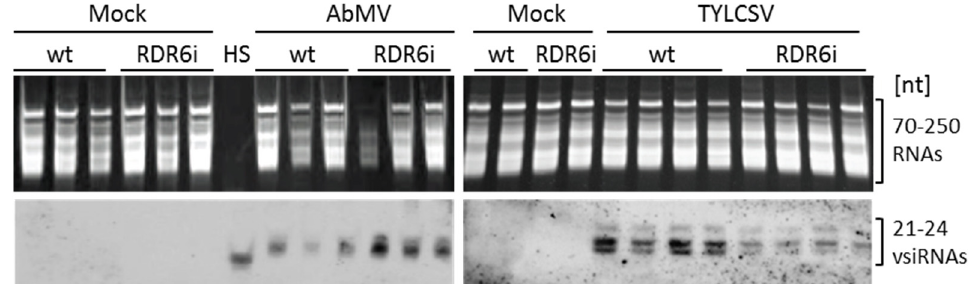
Figure 4. Northern blot analysis of virus-derived siRNAs in wild type (wt) or RDR6i Nicotiana benthamiana plants, either mock-inoculated (control) or infected by either AbMV or TYLCSV. vsiRNAs were detected using PCR-ampli fi ed, digoxigenin-labelled, full-length virus DNA probes via chemiluminescence. Small RNA ( ≈ 70 to ≈ 250 nt apparent lengths) loads of the corresponding denaturing polyacrylamide gels ( above panel , Sybr Gold stain) are shown as loading control. HS, an AbMV-derived DNA oligonucleotide (from ORF C1), was used as a hybridisation speci fi city standard.